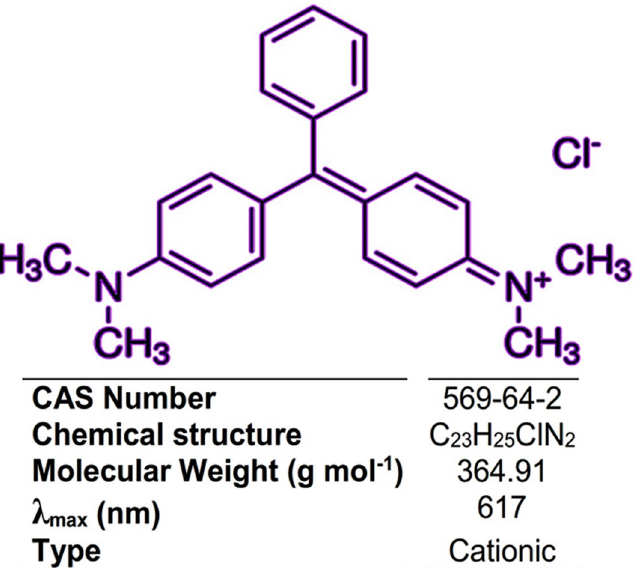
Figure 1. Chemical structure of MG